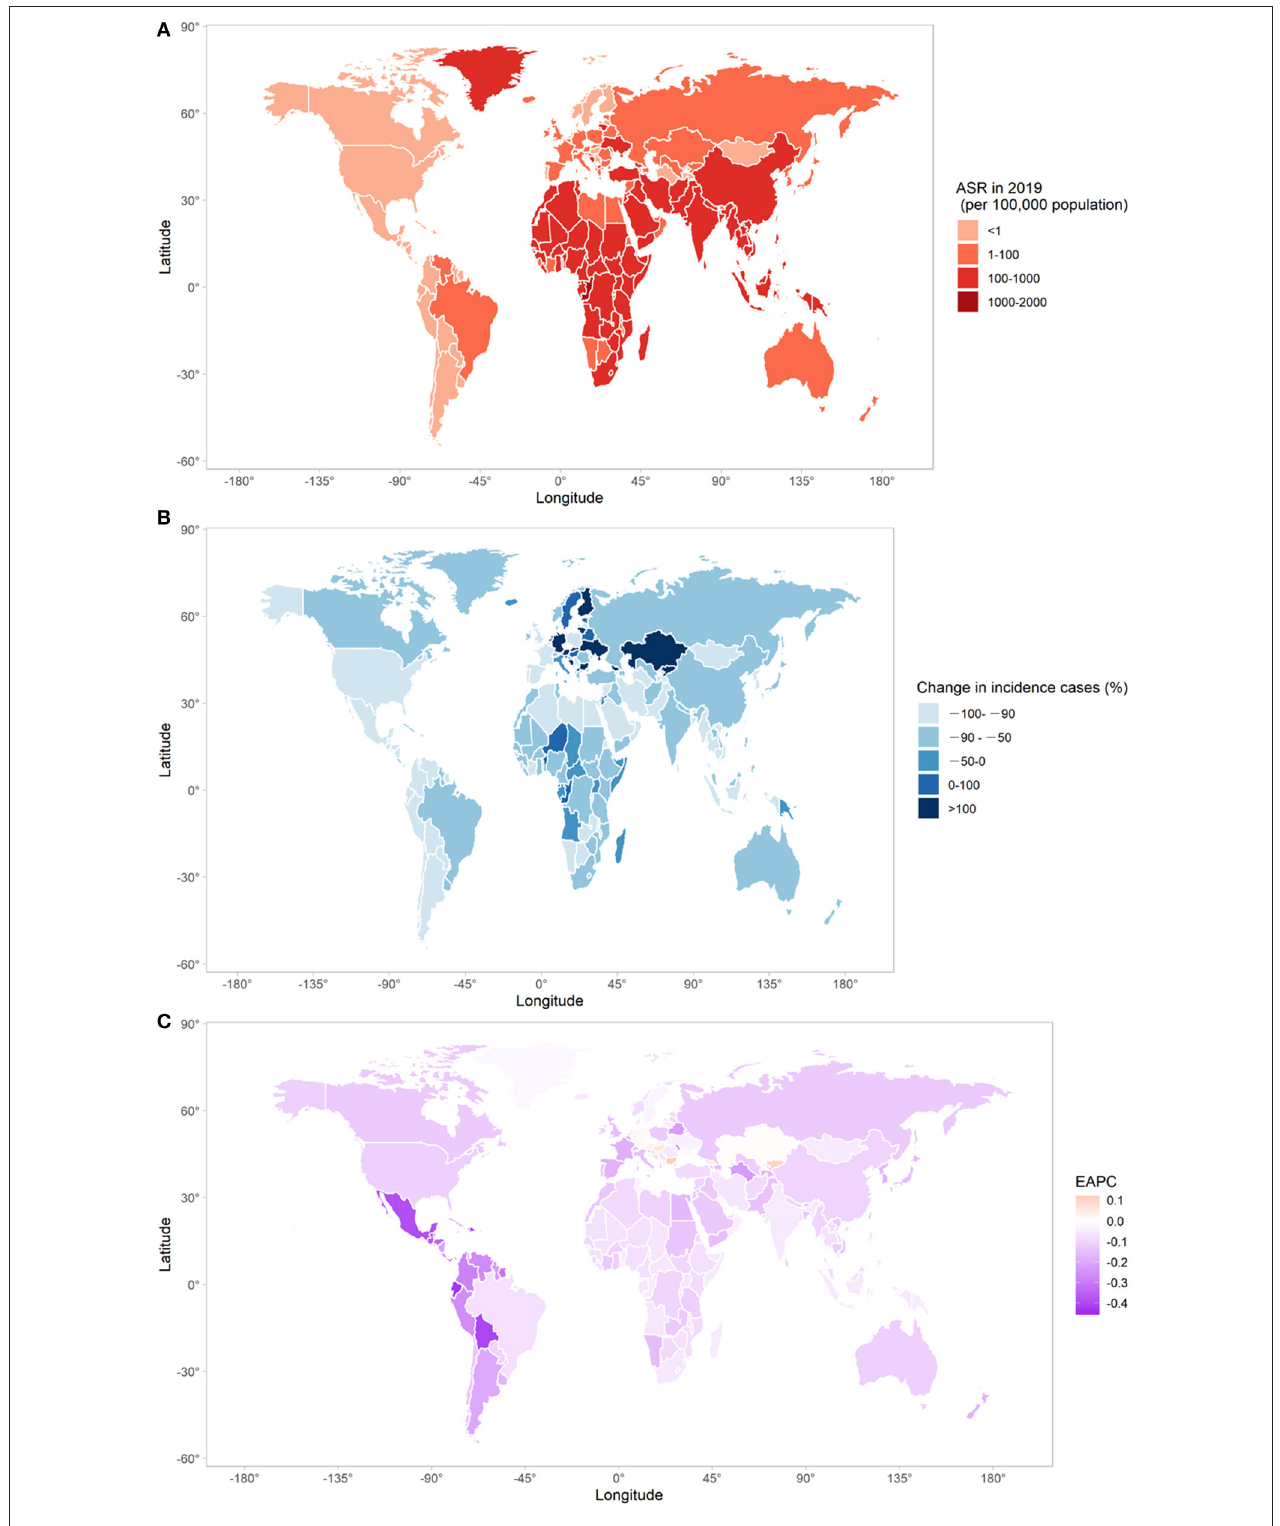
FIGURE 2 | The global trends in measles incidence in 204 countries and territories. (A) The ASR of measles in 2019; (B) changes in number of measles incidence cases between 1990 and 2019; (C) the EAPC of measles ASR from 1990 to 2019. ASR, age-standardized rate; EAPC, estimated annual percentage change.